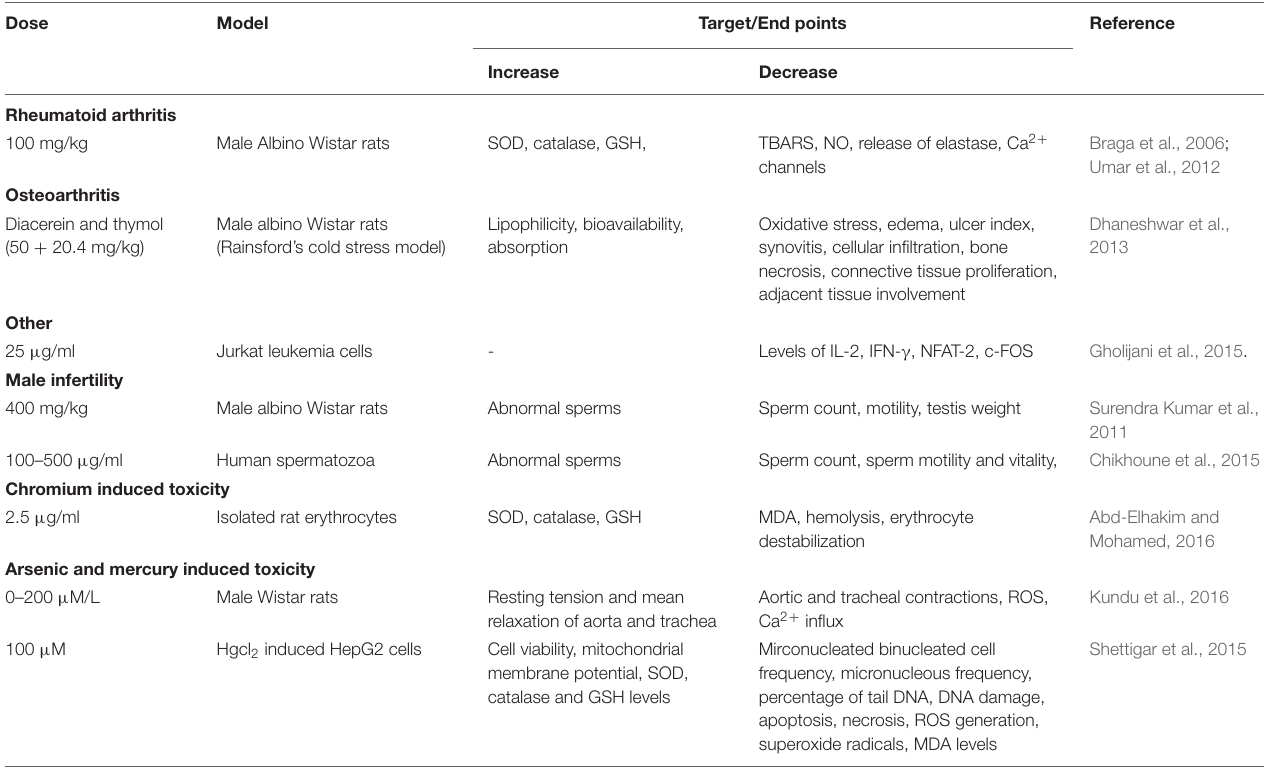
TABLE 8 | Effect of thymol in different experimental models of autoimmune diseases, reproductive and metal induced